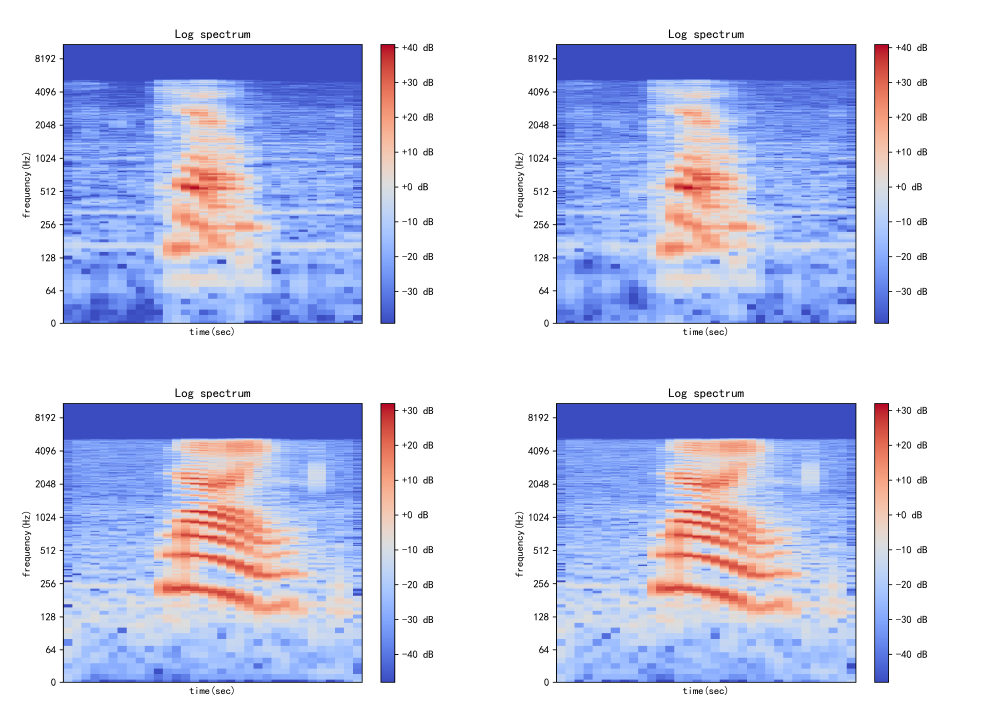
Figure 13. The log spectrogram. The left column is the log spectrogram of the secret audios, and the right column is log spectrogram of the reconstructed secret